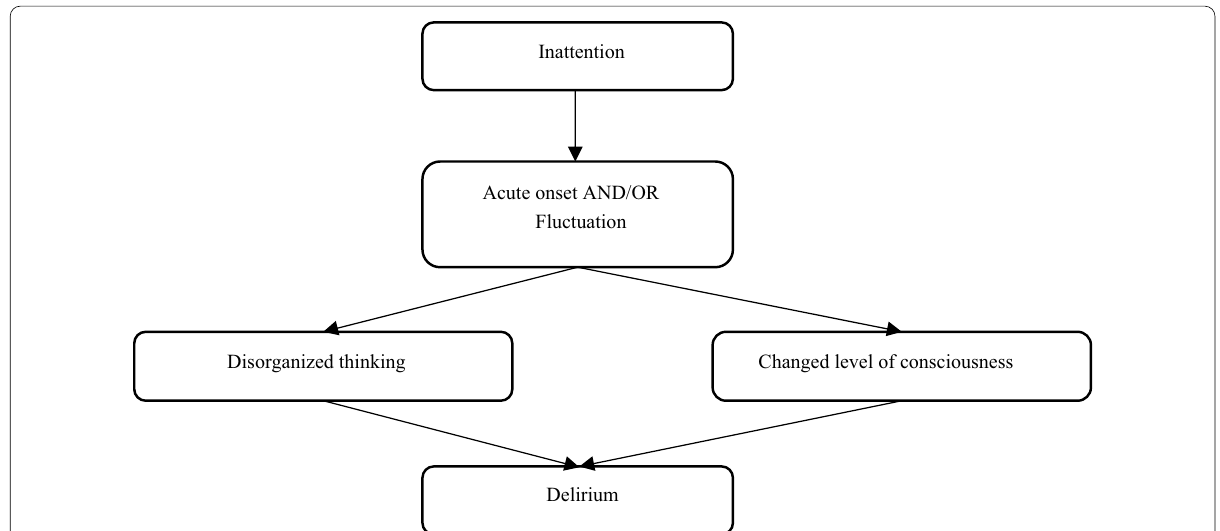
Fig. 1 Algorithm of the modified Confusion Assessment Method for the Emergency Department for the detection of